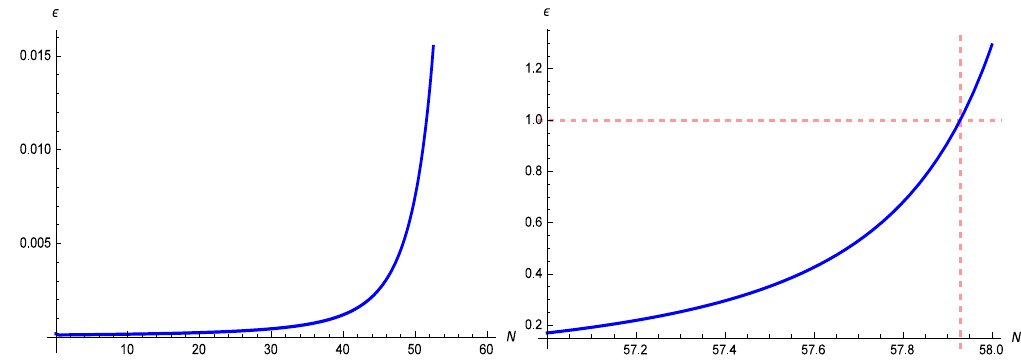
Figure 5 . Evolution of the ǫ -parameter as a function of the number of efoldings N for (left) the entire inflationary dynamics and (right) for the last